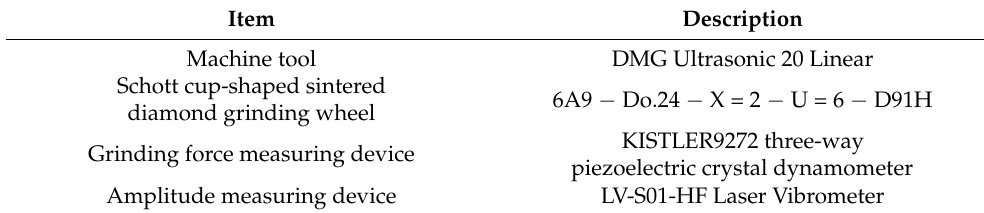
Table 1. Specific parameters of test device.